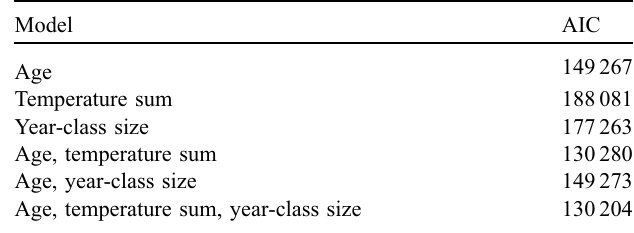
Table 1. AICs from different models used to estimate length increments of pikeperch (log-transformed) based on age, temperature sum, and size of the year-class. The best fi tting model with the smallest AICs was the model using all three variables. All models included intercepts, and temperature sum and year-class size were log-transformed. Total number of increment observations and individuals was 136649 and 24 375, respectively.